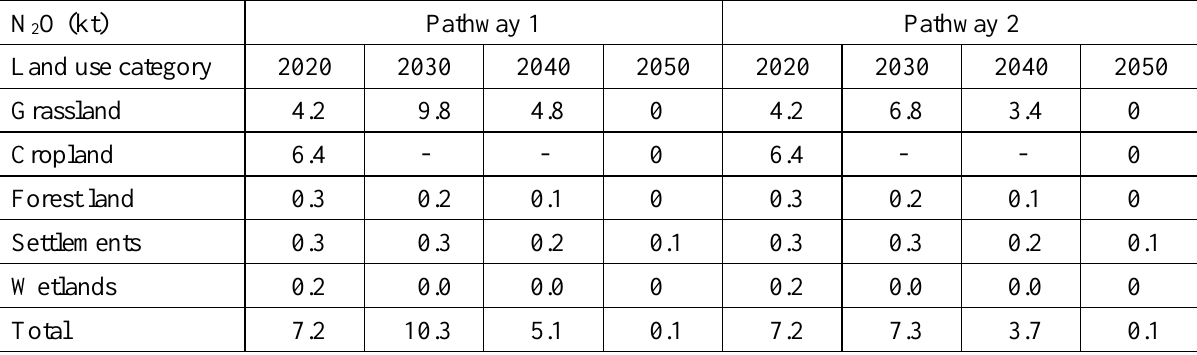
Table A3. N 2 O emissions (in kt) from land use on organic soil in Germany under the proposed emission reduction pathways 1 and 2 (for details, see